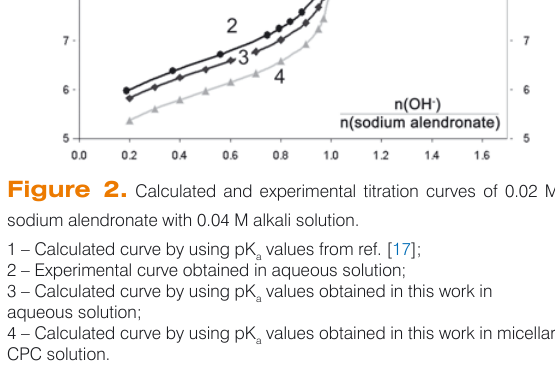
Table 1. Indexes of dissociation constants of aminobisphosphonic acids Literature